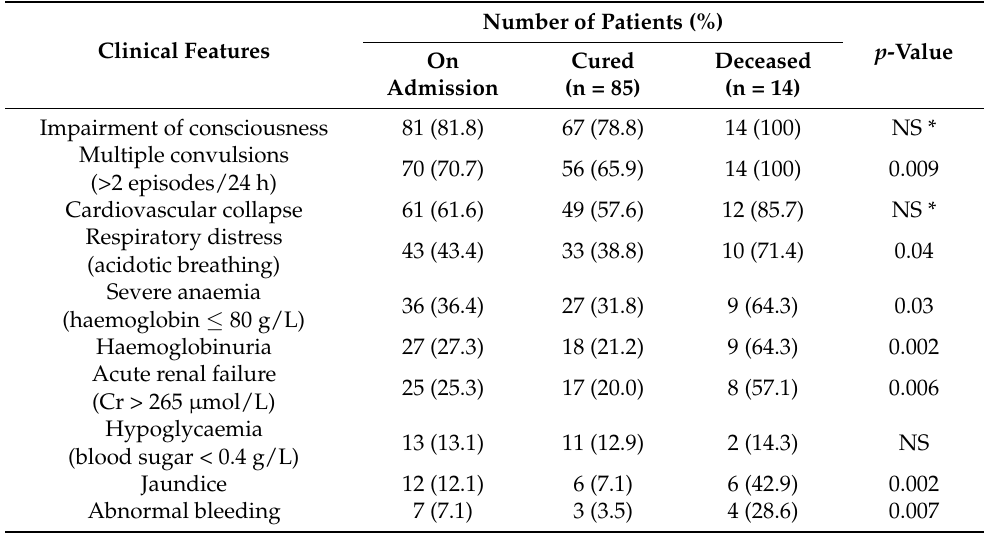
Table 1. Clinical Manifestations of Severe Malaria in Mauritanian Adult